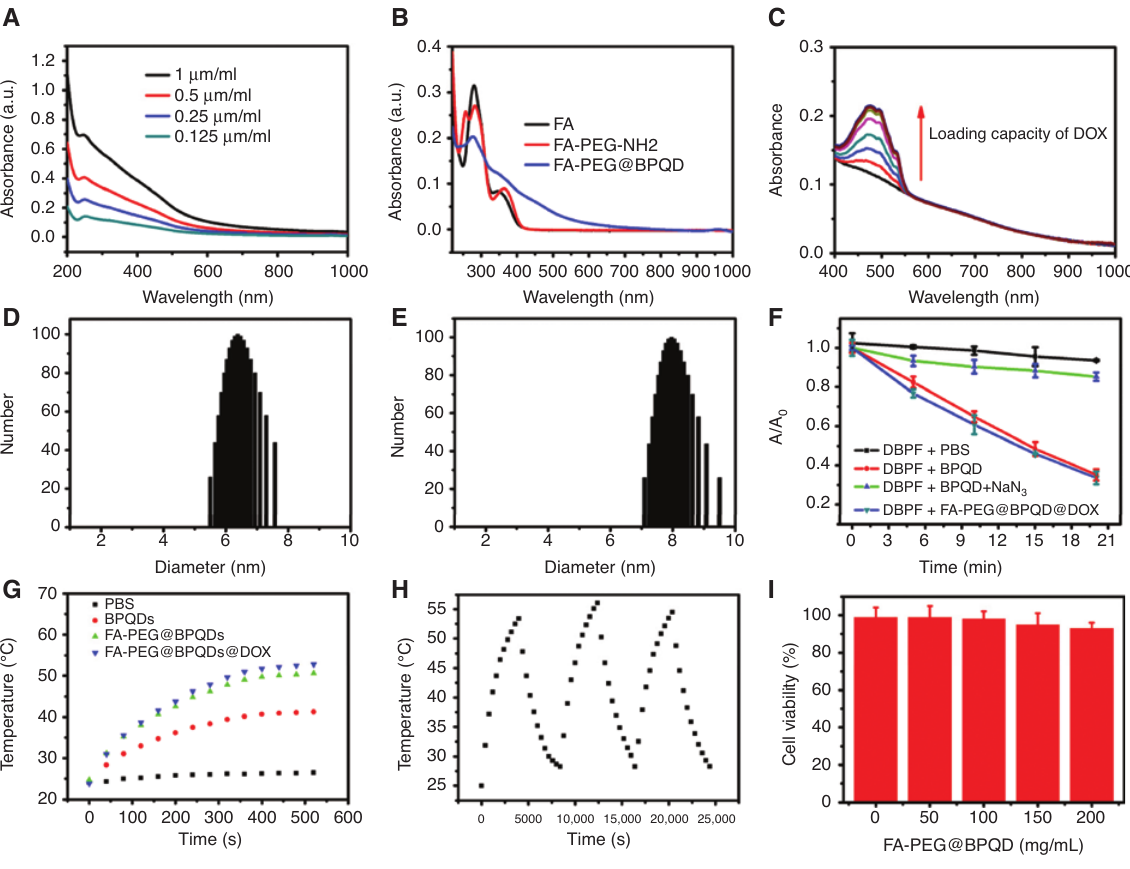
Figure 3: Characterization of FA-PEG@BPQD@DOX. (A) The ultraviolet-vis-NIR spectra of BPQDs of different concentrations in water. (B) The absorbance spectra of FA, FA-PEG-NH BPQD. (C) The DOX loading capacities of FA-PEG@BPQD with different DOX concentrations. (D and E) The particle size distribution of BPQD before and after this was FA-PEG coated and measured by DLS. (F) The normalized absorbance of DPBF when BPQDs were present. (G) The photothermal heating curves of BPQDs in different conditions (1 ml, BPQD = 100 μ g/ml) under laser irradiation (2 W/cm 2 , 808 nm). (H) The photothermal heating/cooling curves of FA-PEG@BPQD@DOX (1 ml, BPQD = 100 μ g/ml) with laser on/off. (I) The viability of 293T cells in various concentrations of